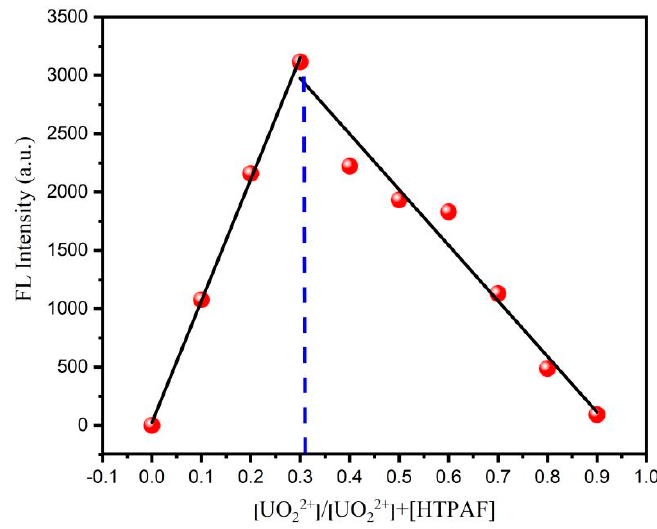
Figure 8. Job’s plot of HTPAF and UO 22+ .